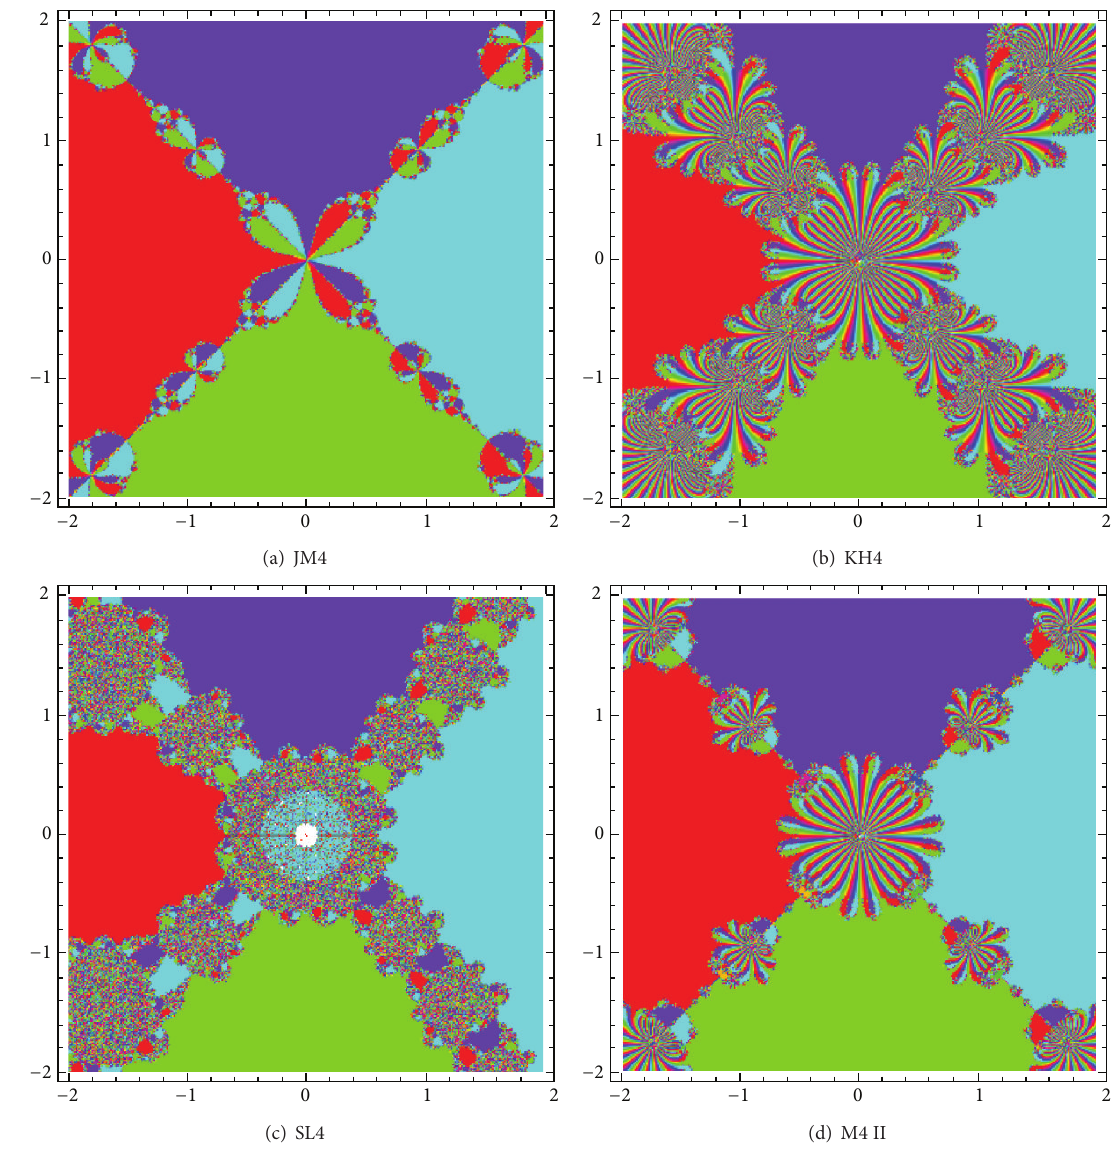
Figure 5: Basin of attraction for polynomial 𝑧 4 − 1